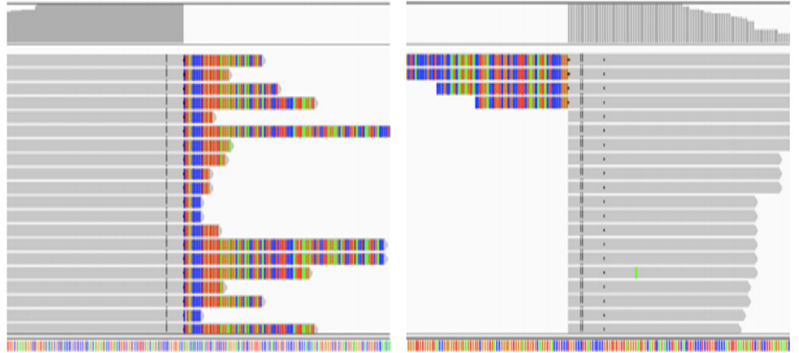
Figure 5. High ‐ throughput sequencing Kit (next ‐ generation sequencing technology,